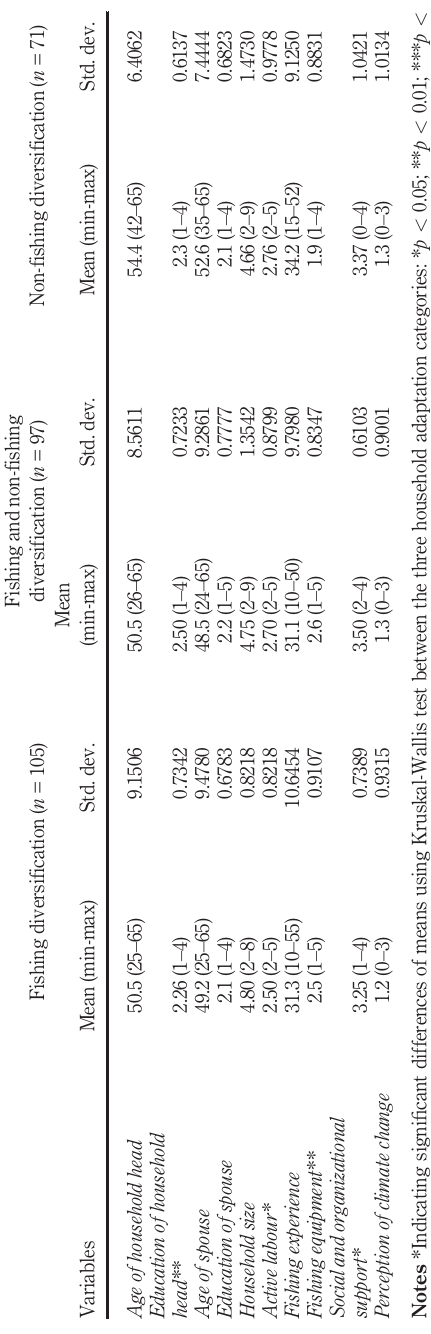
Table 3. Categories of adaptive livelihood strategies used by the sampled fishing households in the research